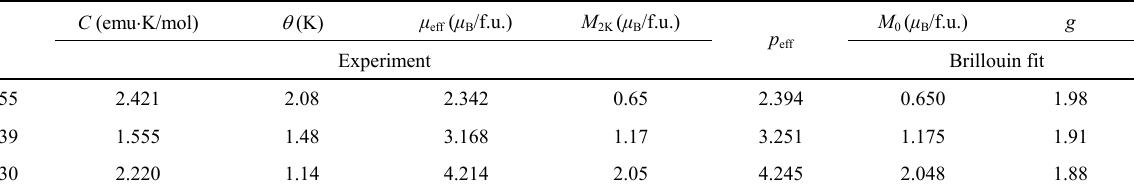
Table 1 Magnetic parameters of the Pb 1–3 x (cid:0) x Gd 2 x (MoO 4 ) 1–3 x (WO 4 ) 3 x nanoparticles: C is the Curie constant,  is the Curie–Weiss temperature, μ eff is the effective magnetic moment, M is the magnetization at 2 K and in the magnetic field of 70 kOe, p eff is the effective number of Bohr magnetons, M 0 is the magnetization at the highest value of H/T , and g is the Landé factor C (emu  K/mol)  (K) μ eff ( μ B /f.u.)